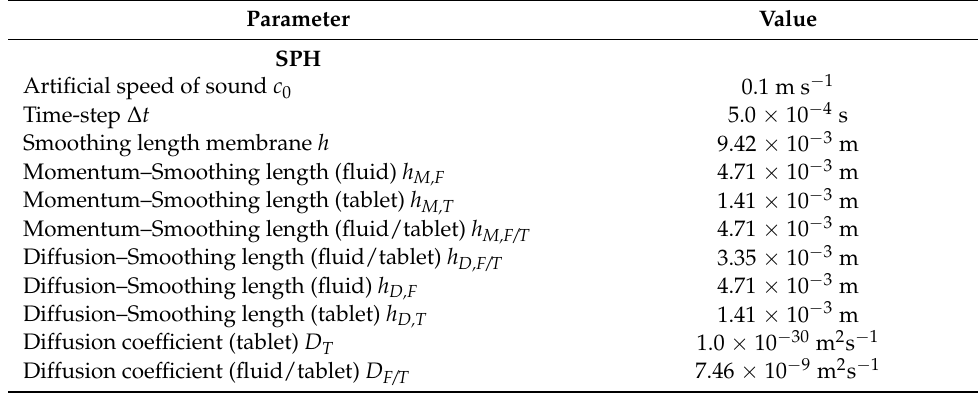
Table 3. Fundamental model parameter.